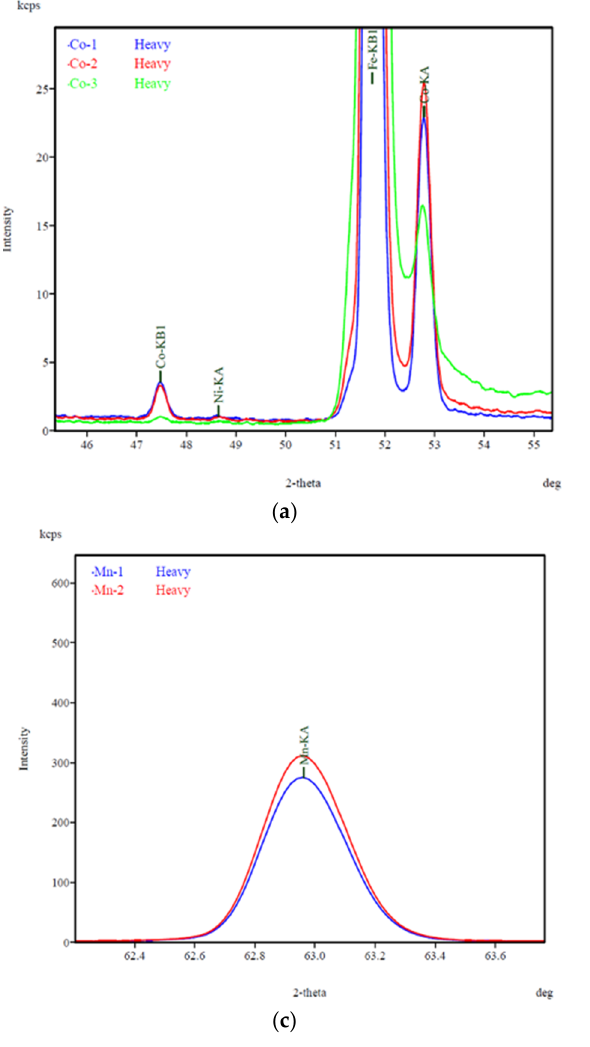
Figure 5. XRF analysis result. ( a ) Result of Co; ( b ) result of Cr; ( c ) result of Mn; ( d ) result of Cs. Table 8. XRF analysis results of weight percent of metal oxide.